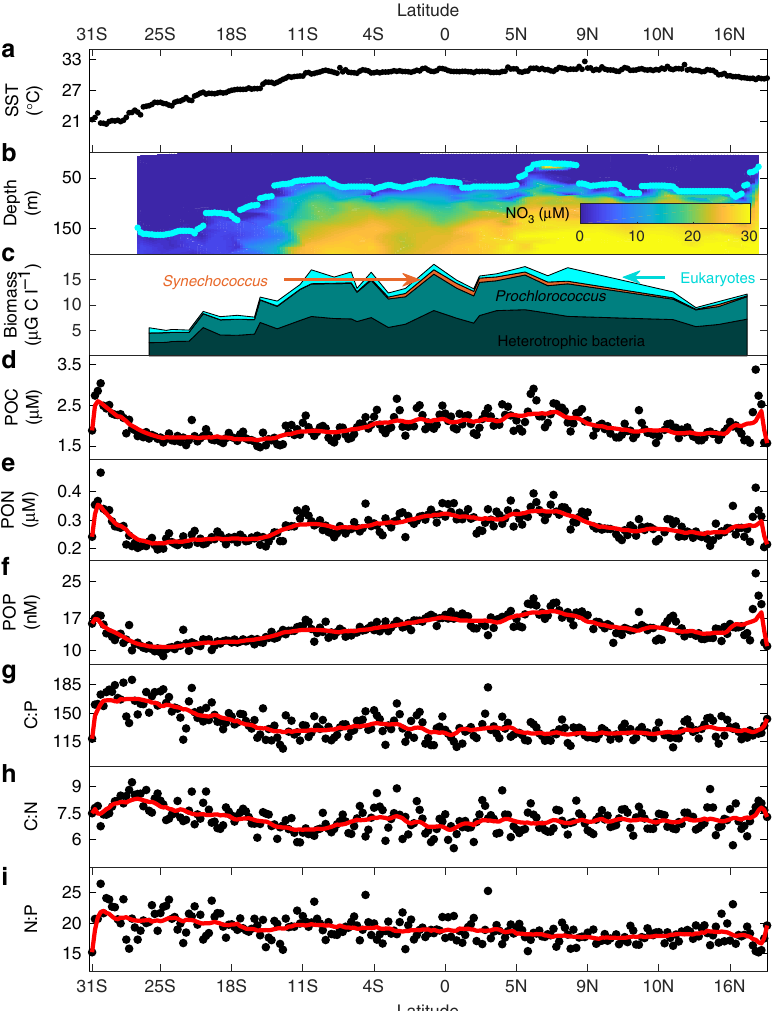
Fig. 2 Observations of environmental conditions, relative phytoplankton biomass, POM concentrations, and ratios across the eastern tropical Indian Ocean. a Sea surface temperatures; b nitrate concentrations as shaded background and nutricline depth (depth with 1 µ M [NO 3 ]) marked by light blue dots; c Phytoplankton absolute biomass; d particulate organic carbon (POC); e particulate organic nitrogen (PON); f particulate organic phosphorus (POP); g POC:POP (C:P); h POC:PON (C:N); and i PON:POP (N:P). In panels d – i , averages of analytical triplicates are marked by black dots, the red line represents an 8-sample moving average, and elemental ratios are molar. First and last 4 end points are averaged over fewer than 8 points. For bacteria and phytoplankton: Bact(dark green) = Heterotrophic bacteria, Pro(greenblue) = Prochlorococcus , Syn(orange) = Synechococcus , and Euks(cyan) =